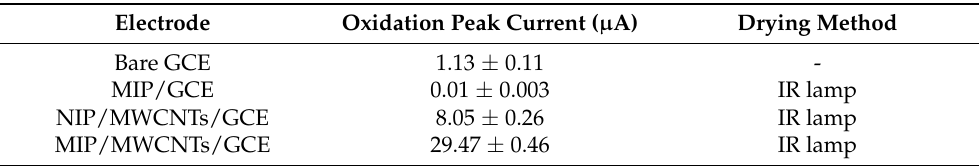
Figure 3. MIP/MWCNTs/GCE (a), NIP/MWCNTs/GCE (b), bare GCE (c), and MIP/GCE (d) in 20 mL B-R buffer (pH 10.0) containing 500 µM MDA. Table 1. Comparison of the electrocatalytic oxidation peak current ( I p ) of MDA (500 µ M) on various electrode surfaces at pH